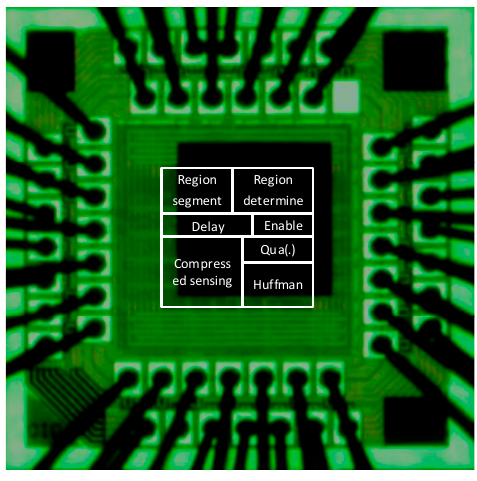
Figure 8. Photomicrograph of the proposed chip.